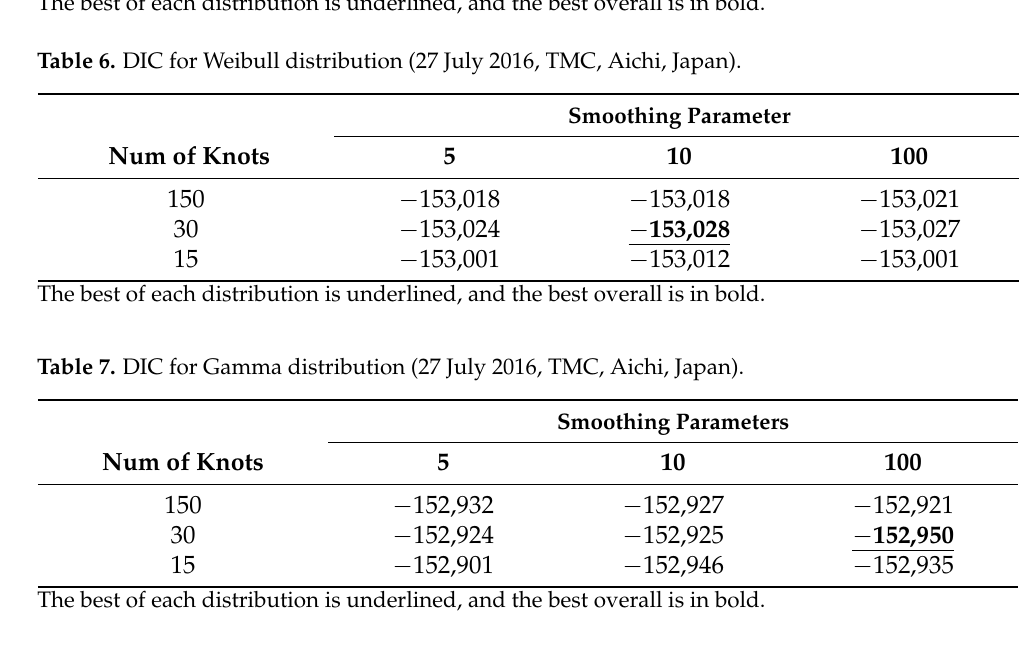
Smoothing Parameters